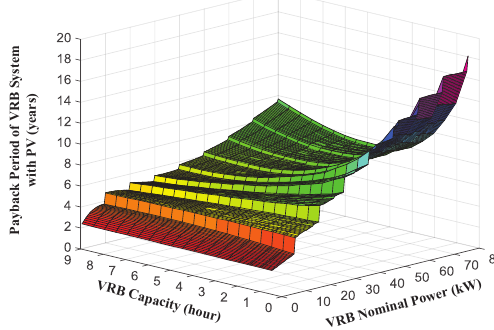
Figure 11. Payback period of the VRB system with PV